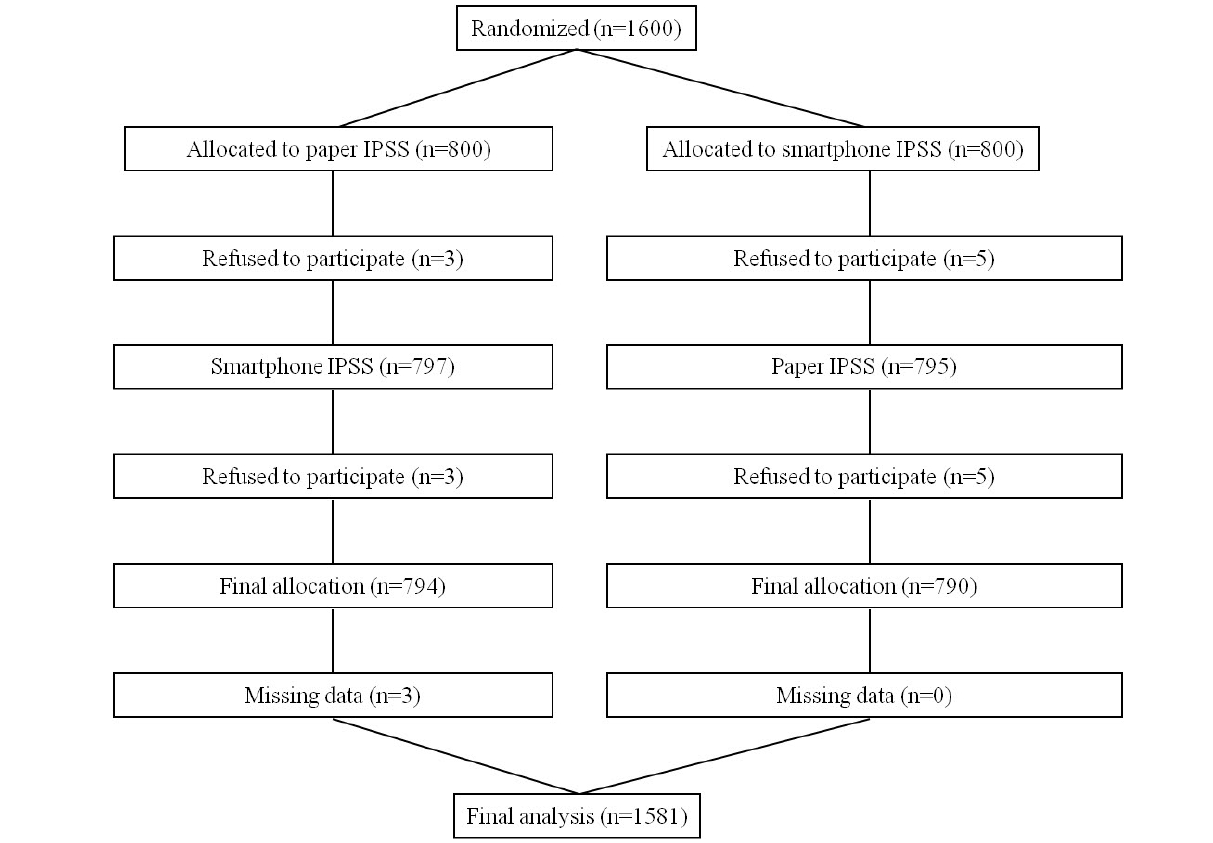
Figure 1. Flow chart of study